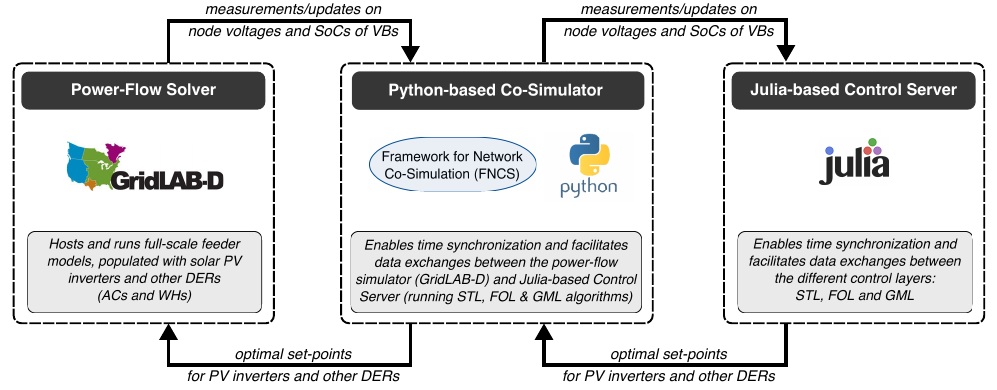
Figure 14. The integrated co-simulation environment for numerical validation of the coupled hierarchical stochastic control algorithms (STL, FOL and GML) with large-scale simulations of distribution feeder models populated with solar PV and other